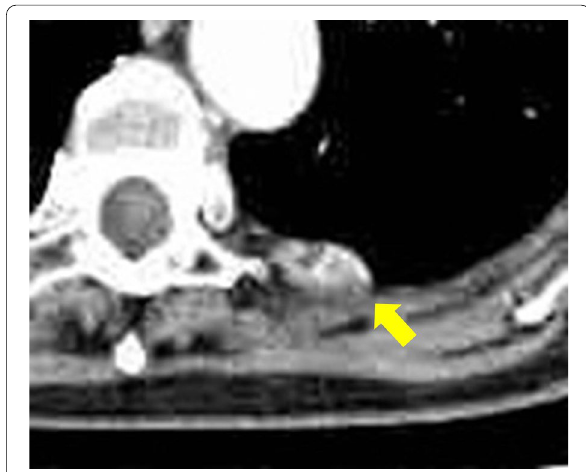
Fig. 1 Enhanced chest CT scan findings. Enhanced chest CT showed an about 22-mm-sized heterogeneous enhanced nodule in the left